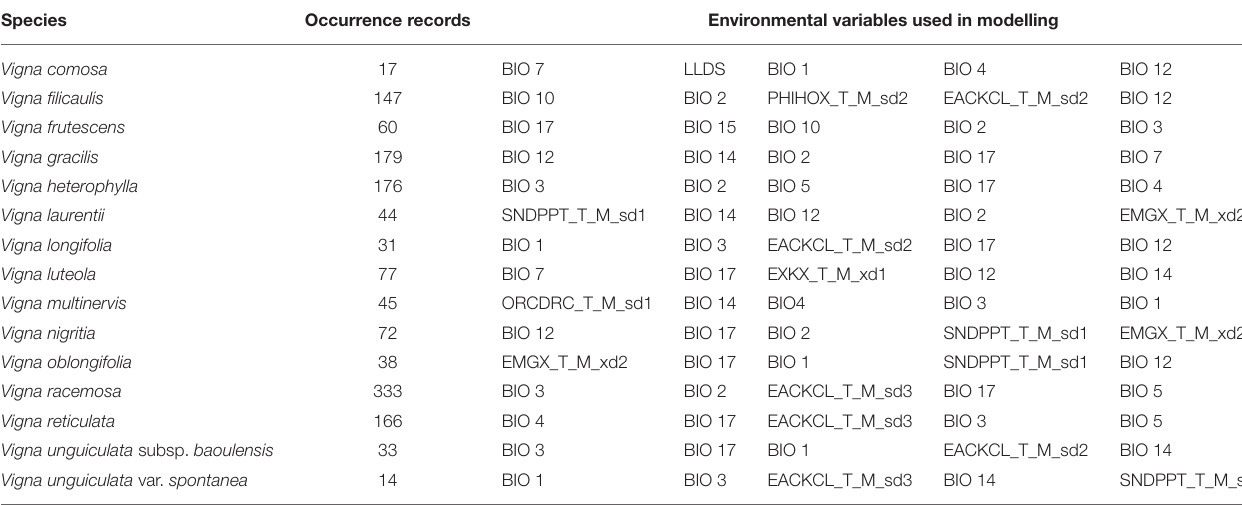
TABLE 1 | Occurrence records and environmental variables used for modelling the 15 Vigna CWR taxa in Benin.